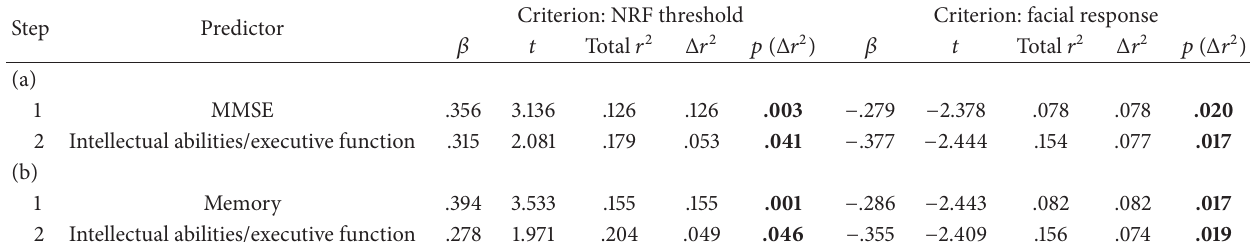
Table4:Linearregressionsanalyses(blockwise)showingthepredictivepowerof“intellectualabilities/executivefunction”toexplainvariance in pain responsiveness (NFR threshold and facial responses) after controlling for (a) the general cognitive functioning and (b) memory